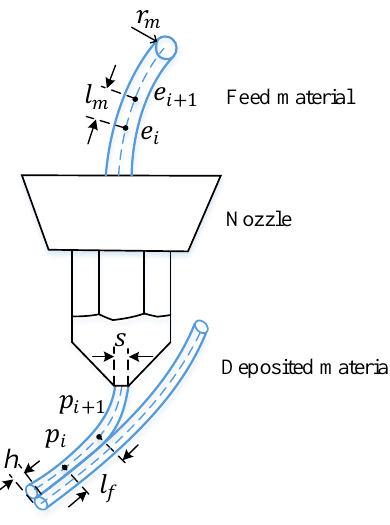
Figure 6. Illustration of material extrusion